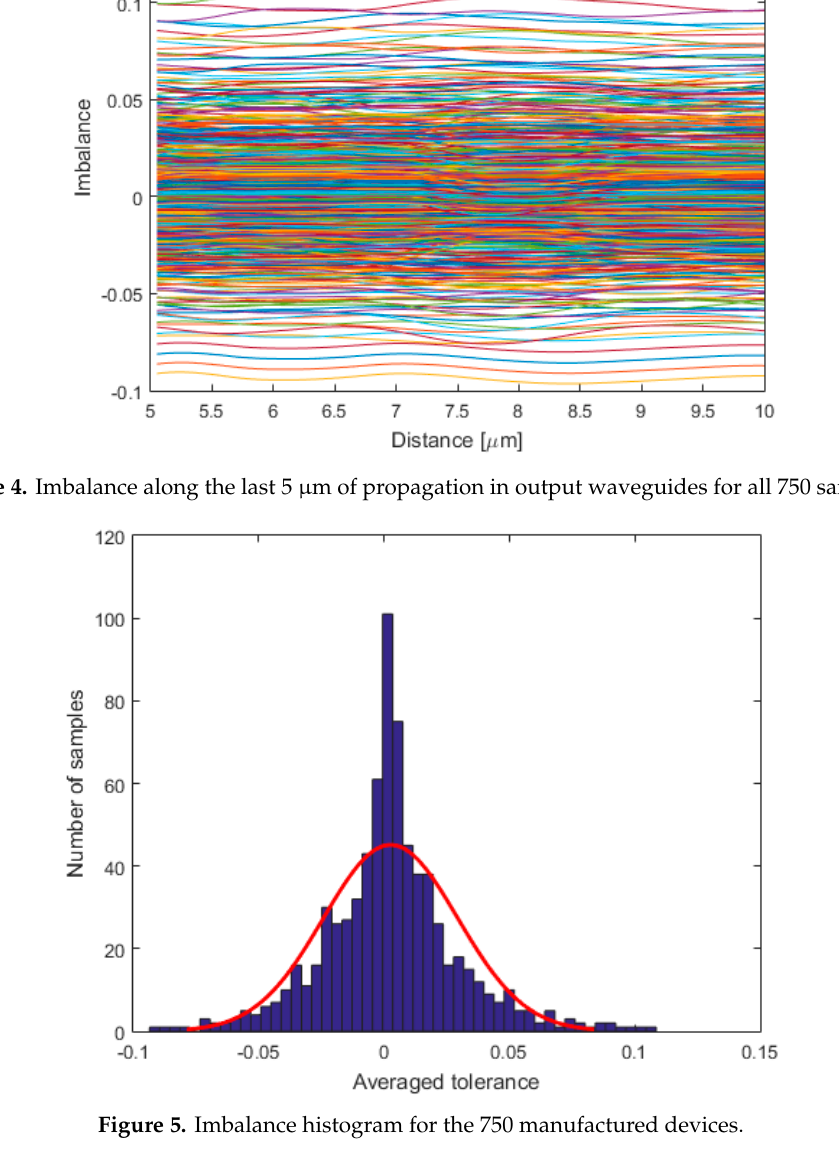
Figure 5. Imbalance histogram for the 750 manufactured devices.